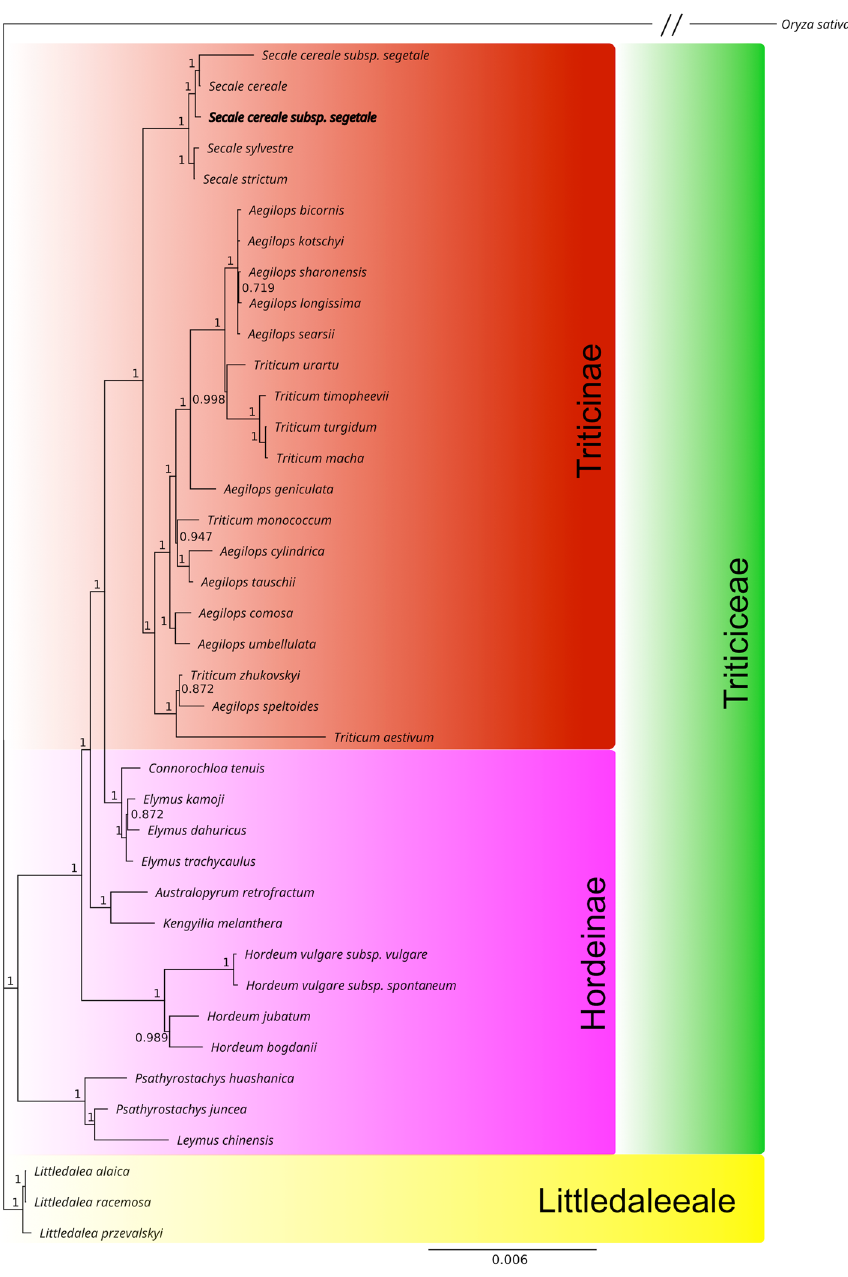
Figure 2. Cladogram illustrating the phylogenetic relationships for Secale cereale ssb . segetale based on complete cp genome sequences. Phylogenetic tree based on sequences of sheared 73 protein-coding genes from five Secale species and 34 other cereal lineages representing Triticodae group within subfamily Pooidae and the cp genome of Oryza sativa as an outgroup, using Bayesian posterior probabilities (PP) and maximum likelihood (ML). Each node has 100% bootstrap support value. The cpDNA sequence obtained in this study is shown in